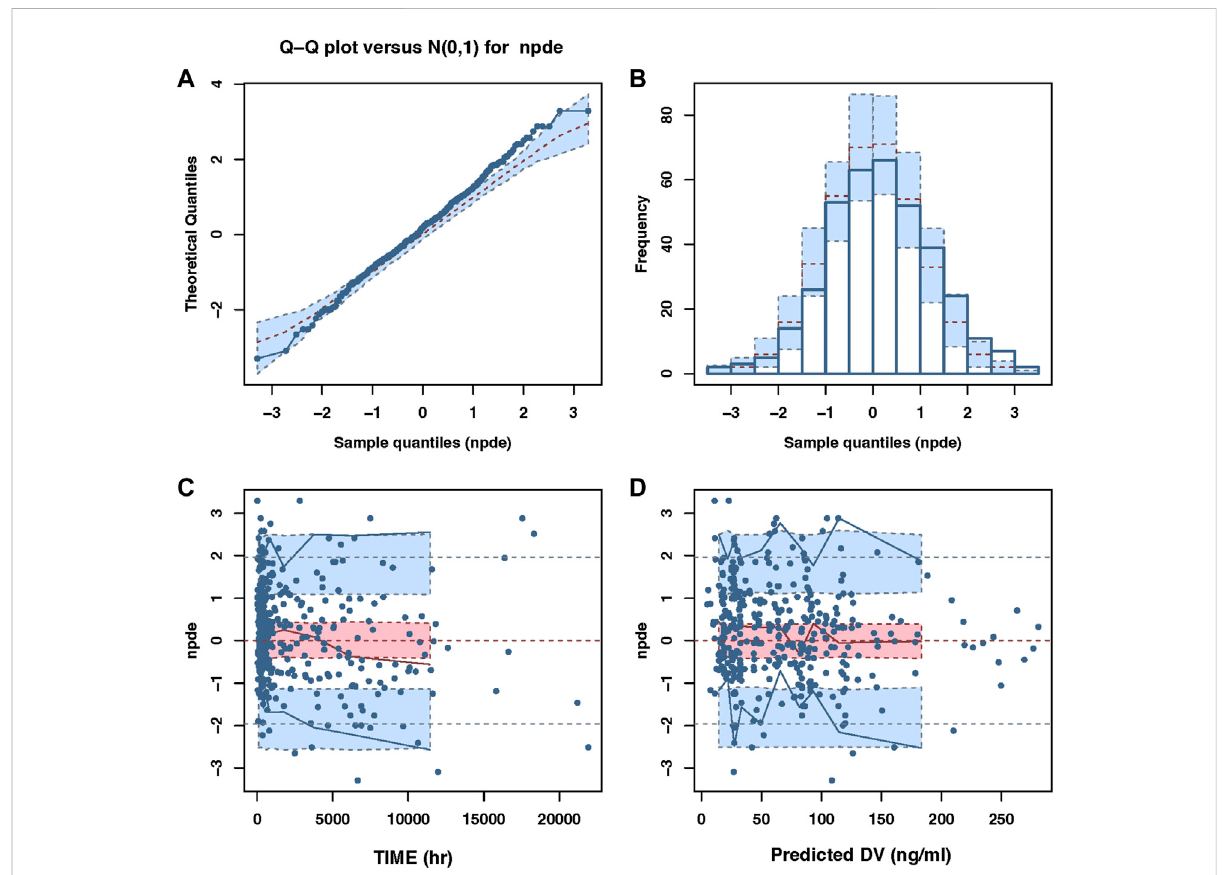
FIGURE 2 TheNPDEplotsofthepopulationPKmodel. (A) Thequantile – quantileplot (B) thedistributionhistogramofNPDE; (C) theNPDEversustime (D) the NPDE versus predictions